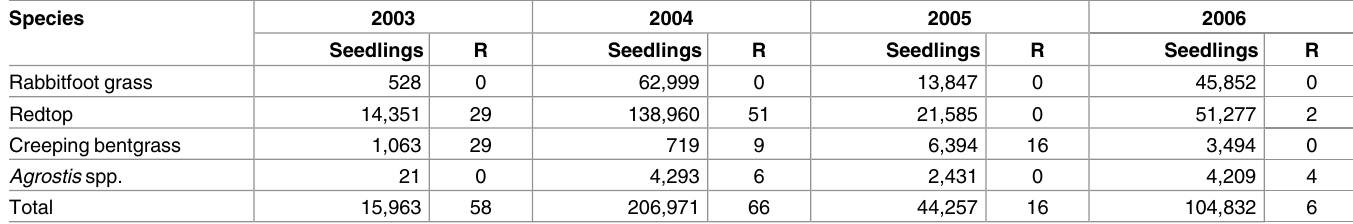
Table 1. Glyphosate screening of seedlings from susceptible established plants. Number of seedlingssprayed (Seedlings) and glyphosate-resistant (R) seedlings, of seed collected in situ from susceptible plants of each species from 2003 through 2006. Species Rabbitfoot grass Redtop Creeping bentgrass Agrostis